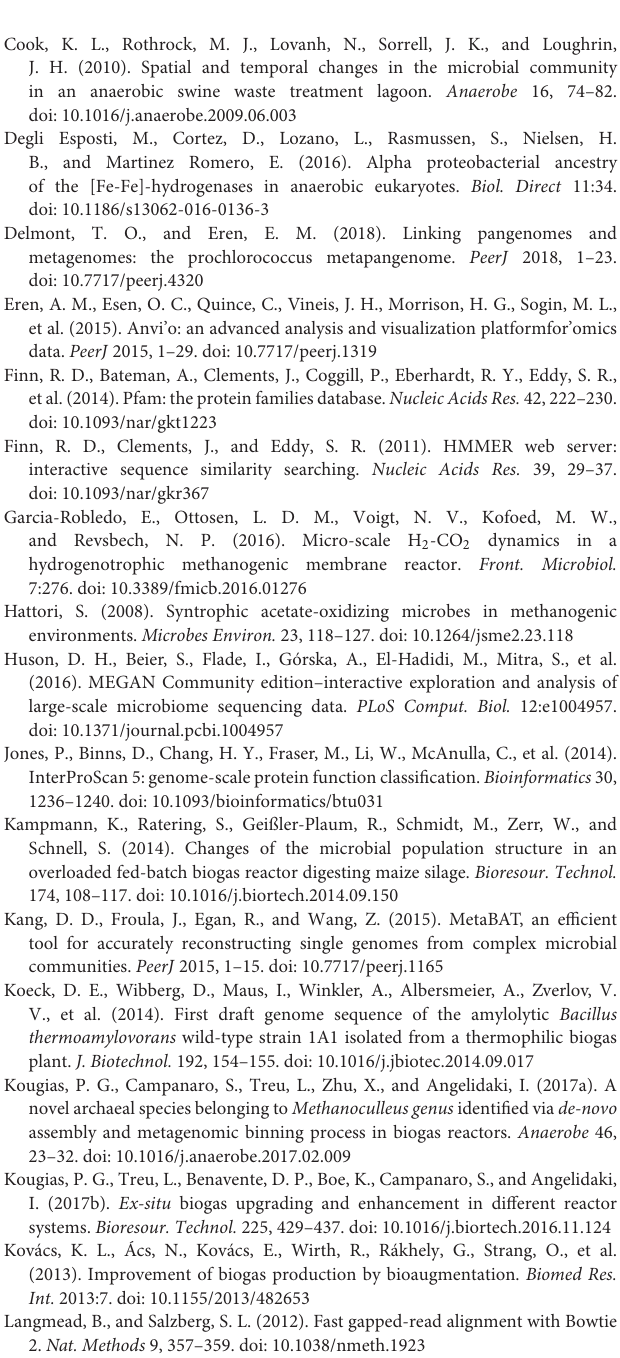
Supplementary Table 2 | Gene calls of the genome-based evaluation. Supplementary Table 3 | The T-RFLP clone